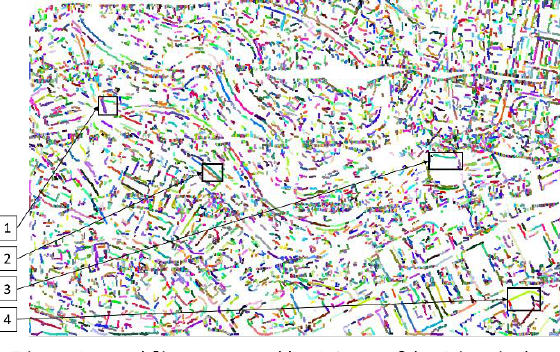
Figure 9. Breaklines extracted by AGPN of the Cite1 in the second dataset.